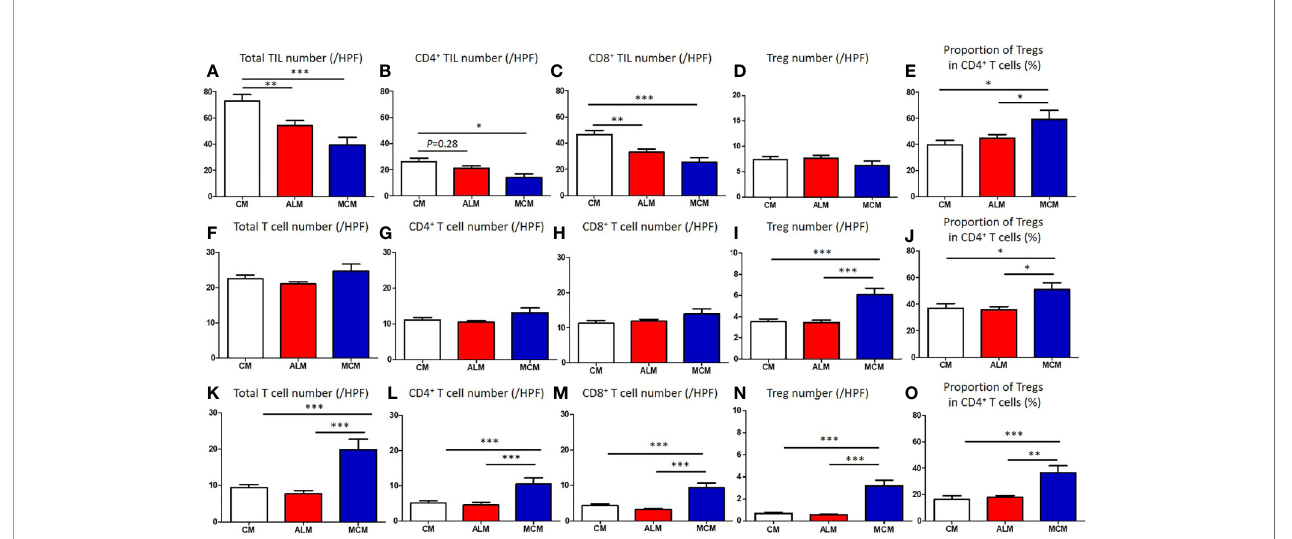
FIGURE 2 | Comparison of T cells in tumor, peritumoral skin/mucosa and distant normal skin/mucosa of each melanoma subtype. (A – O) Numbers of total T cells, CD4 + T cells, CD8 + T cells, regulatory T cells (Tregs) and proportion of Tregs in CD4 + T cells in tumor (A – E) , peritumoral skin/mucosa (F – J) and distant normal skin/ mucosa (K – O) in patients with cutaneous melanoma (CM), acral lentiginous melanoma (ALM) and mucosal melanoma (MCM) were shown. P -values was calculated using Mann-Whitney U test. * P <0.05, **<0.01, *** P